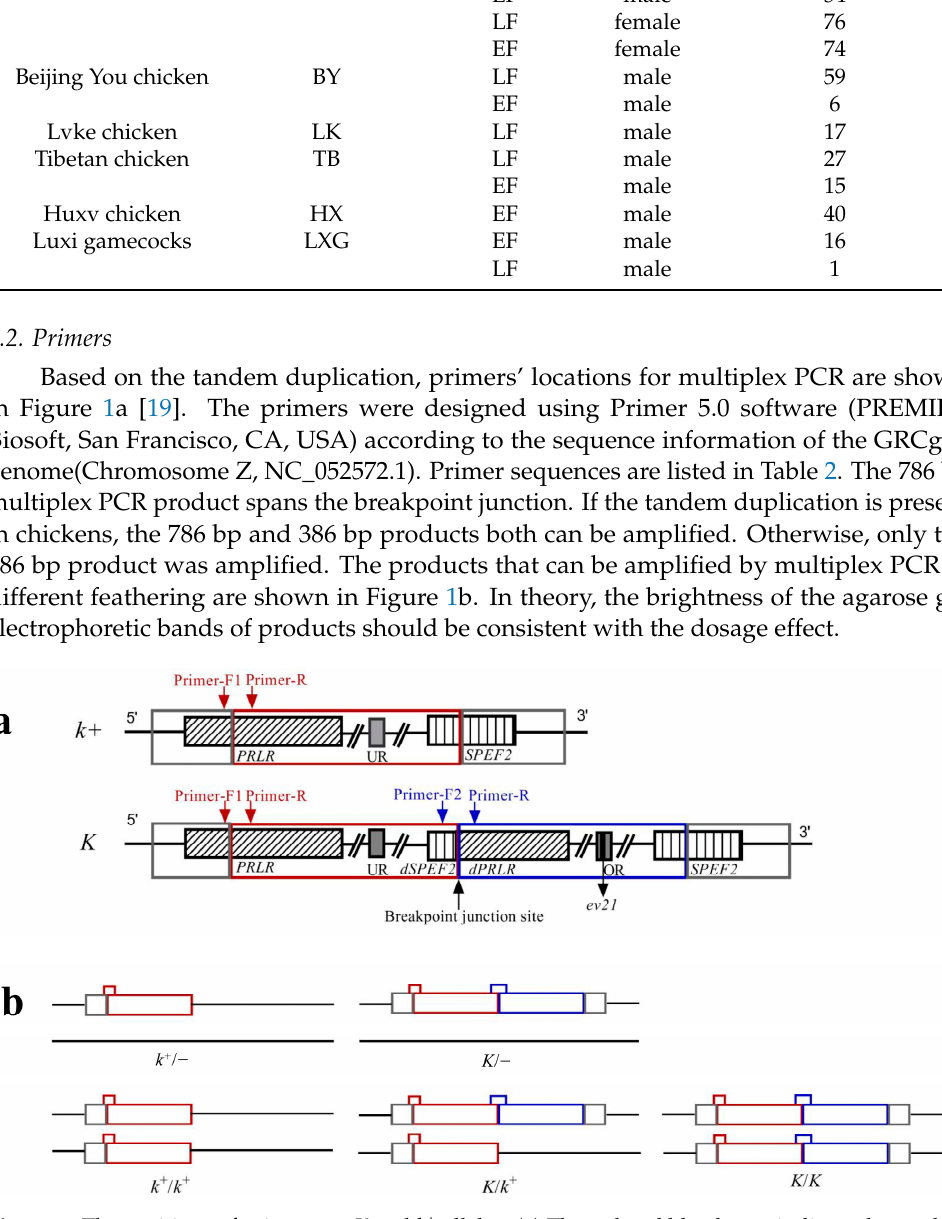
Figure 1. The positions of primers on K and k + alleles. ( a ) The red and blue boxes indicate the tandem duplication block; UR indicates the unoccupied ev21 integration region; OR indicates the occupied ev21 integration region; Primer positions are indicated by red and blue arrows. ( b ) Fragment regions that can be amplified by multiplex PCR with DNA samples from different feathering chickens. The small red box represents the 386 bp fragment amplified by the primer F1-R, and the small blue box represents the 786 bp fragment amplified by the primer F2-R. Within DNA samples, the ratio of the number of 786 bp and 386 bp templates of heterozygote ( K / k + ) and homozygote ( K / K ) is 0.5 and 1.0, respectively. Under the same total DNA concentration, the number of K alleles of LF homozygote ( K / K ) is quite different from that of LF female ( K / − ), and their ratio is 2:1.